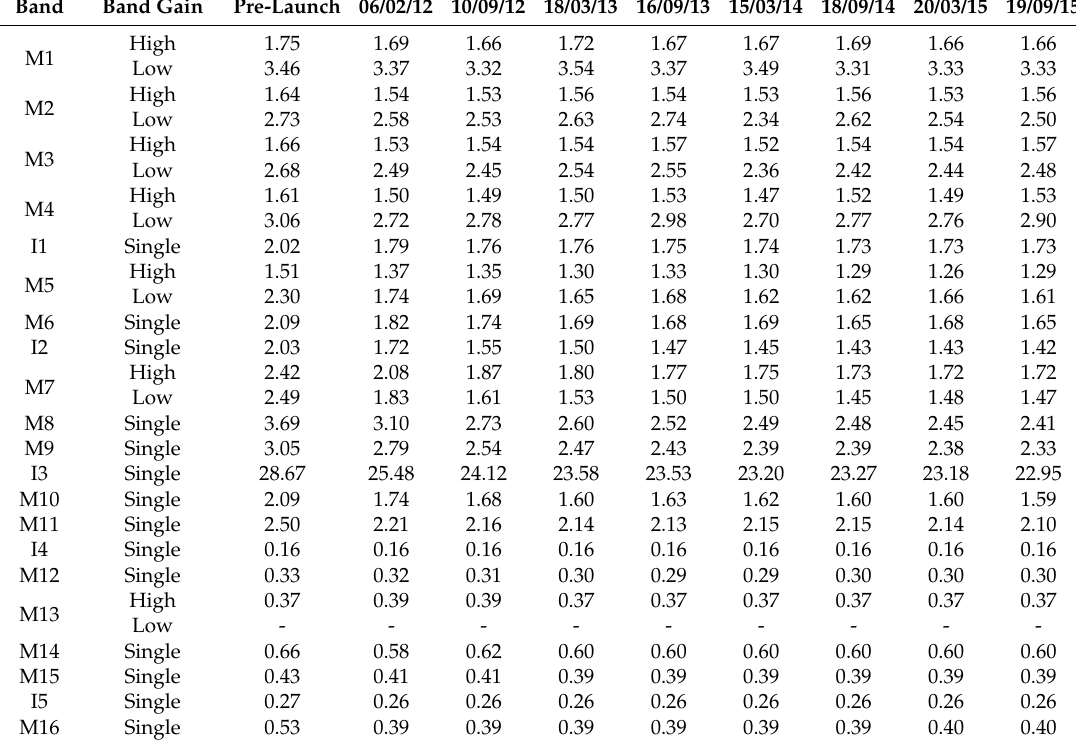
Table 4. VIIRS noise characterization results expressed using ratios between measured SNR (or NEdT) and specified SNR (or NEdT) for RSB (or TEB). The requirements are satisfied if the ratio is greater than one for the RSB and less than one for the